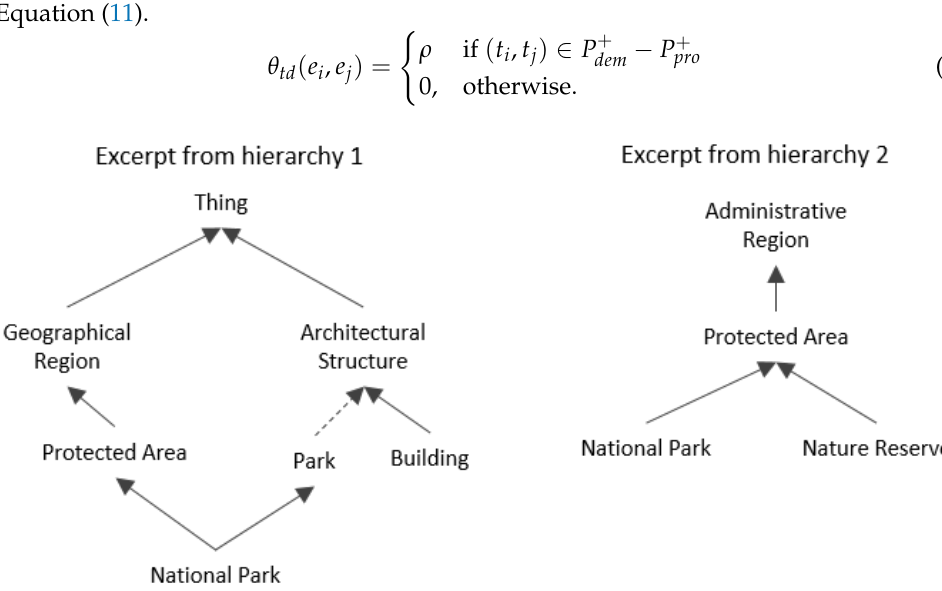
Figure 2. Example of erroneous subClassOf axiom in a hierarchy resulting in wrong